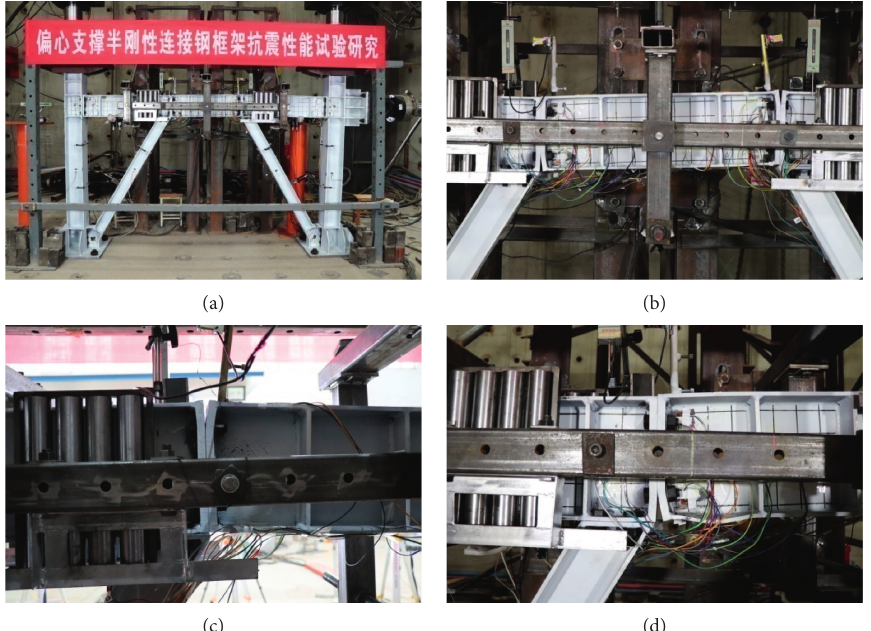
Figure 14: Experimental phenomena of specimen PDKB-3. (a) Deformation at 4 δ (d) Deformation at 8 δ y